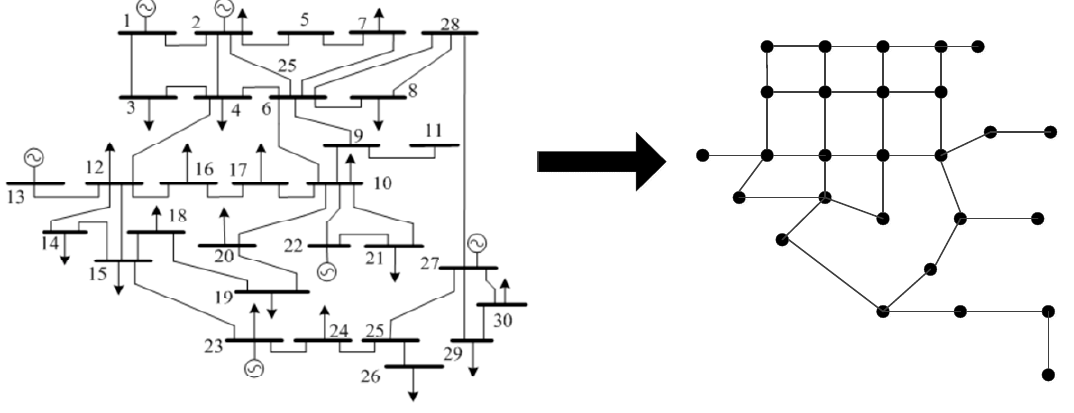
Figure 2. Constructing power system structure into graph structure.